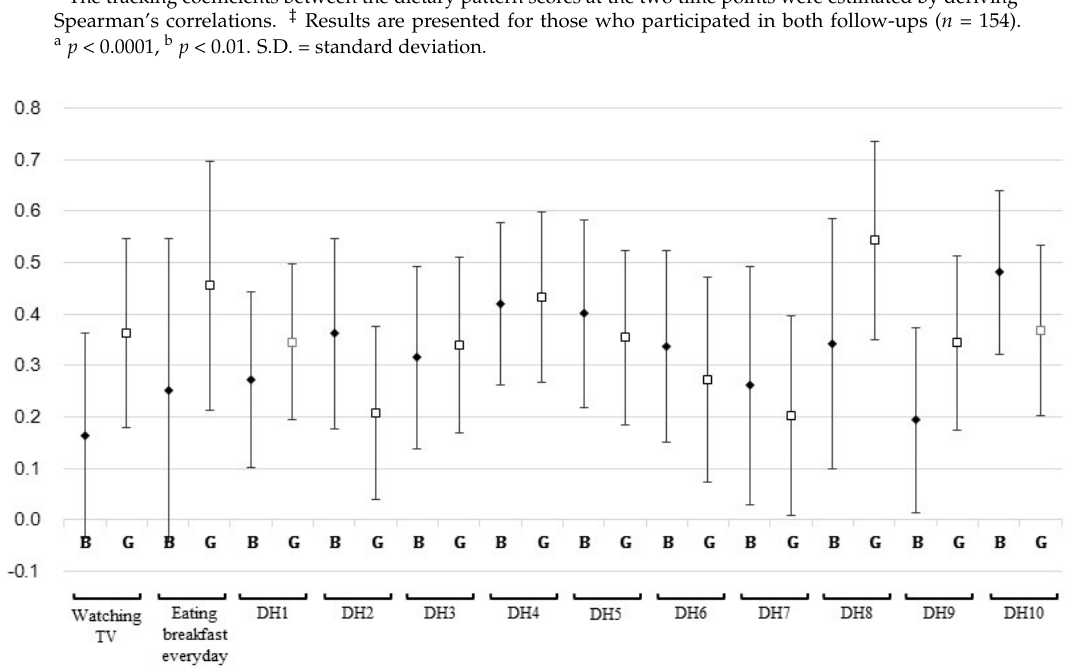
table salt or soy sauce to food. DH8: Eating three regular meals per day. DH9: Eating ice cream, cake, snacks, and soda (e.g., cola, cider) as snacks more than twice a week. DH10: Eating a variety of